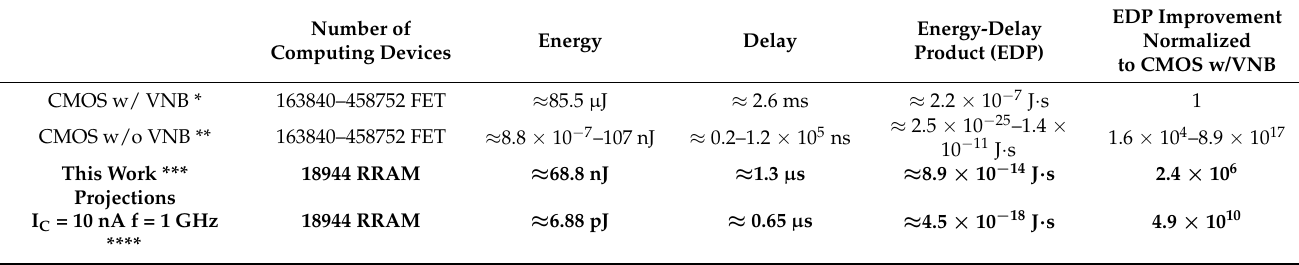
Table 5. Comparison between the proposed FA and a CMOS FA when executing 512 parallel 32-bit FA operations (4 kB data). Number of Computing